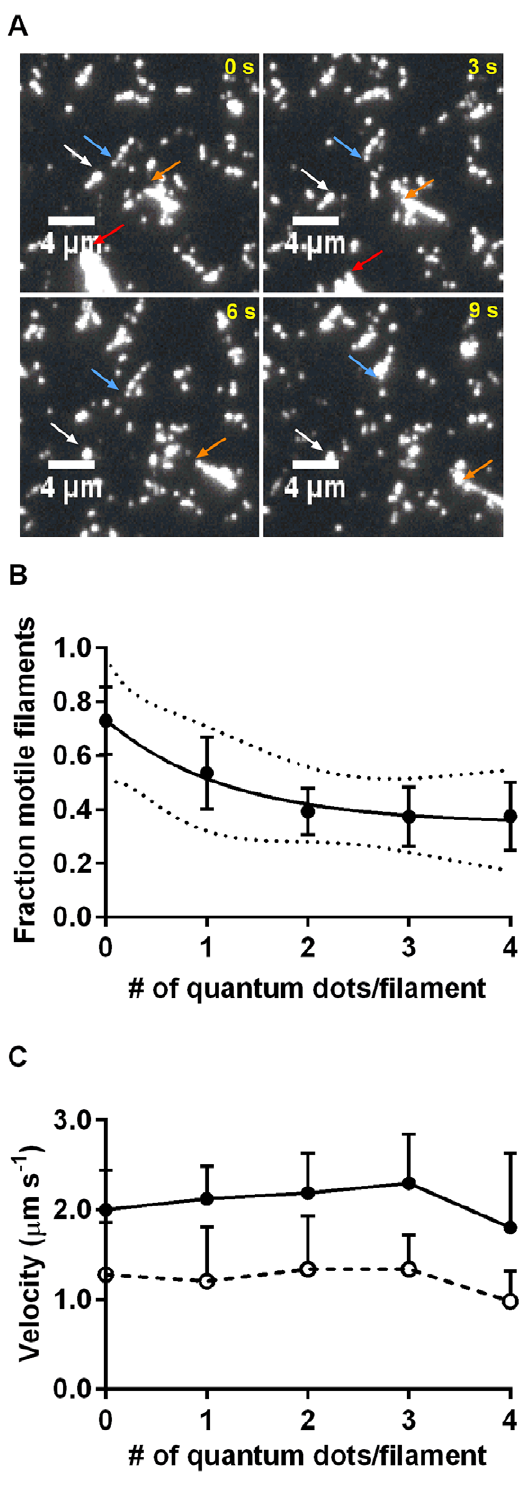
Figure 3. Motility quality vs. number of attached quantum dots on HMM propelled filaments. A. Fluorescence micrograph time series at 3 s intervals showing several motile and some non-motile and heavily quantum dot labelled actin filaments. All fluorescence in the micrographs is attributed to the quantum dots. The colour coded arrows point to some motile filaments/aggregates with 5 quantum dots (blue arrow; apparently single filament), . 5 quantum dots and presumably 2 cross-linked filaments (orange arrow), small